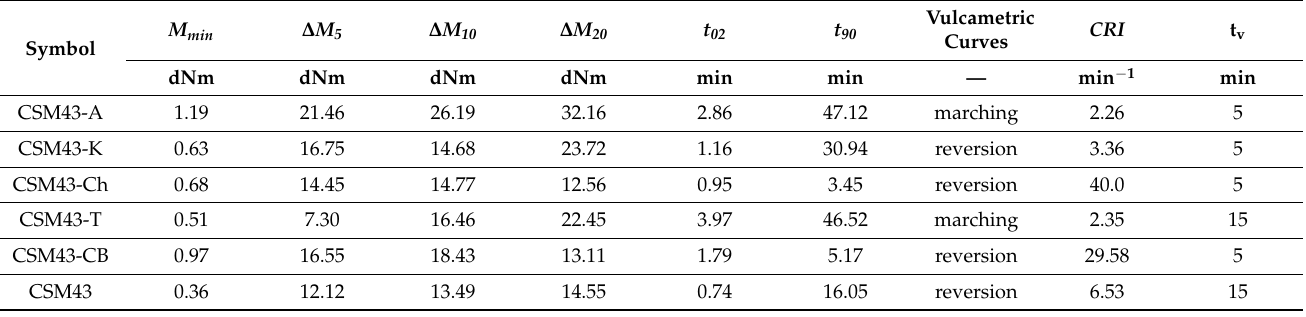
Explanation of symbols: under Table 2.